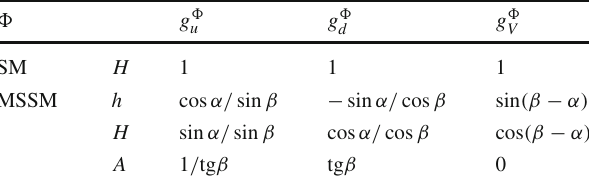
Table 1 MSSM Higgs couplings to SM particles relative to the SM Higgs